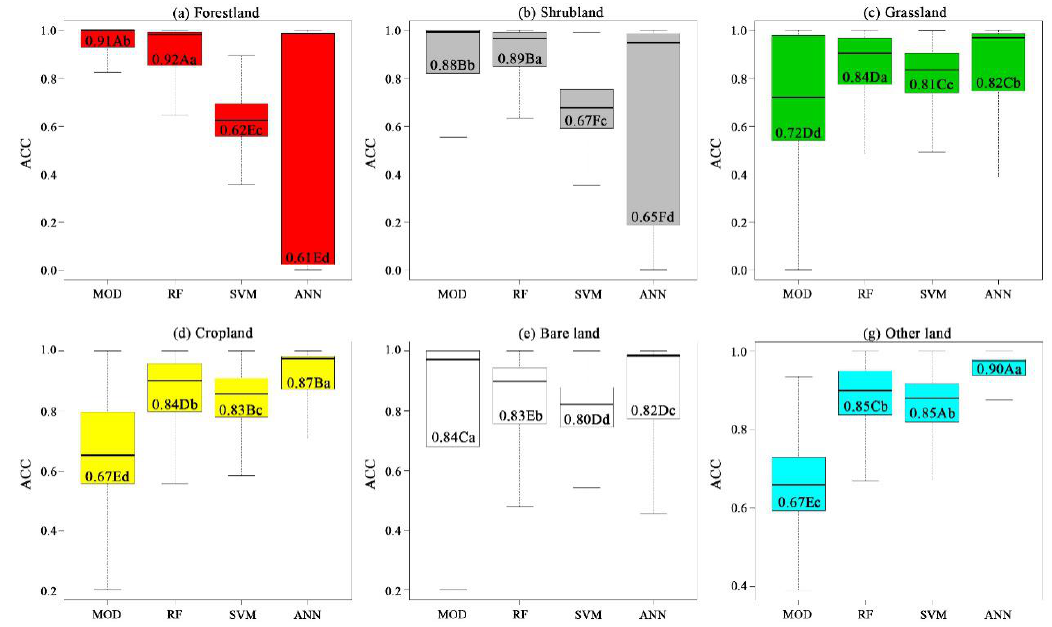
Figure 6. Boxplots of the accuracy distributions of MOD10A1 (MOD), random forest (RF), support vector machine (SVM) and back-propagation artificial neural network (ANN) under different land cover types over the Tibetan Plateau. Labels are composed of the average accuracy and the results of the significance tests (in the case of p < 0.05). The uppercase letters represent the accuracy of the specific model from high to low (A to D) among different land cover types, while the lowercase letters represent the accuracy from high to low (a to d) among the four FSC models for each land cover type. Table 4. Overall average accuracy (ACC) of MOD10A1 (MOD), random forest (RF), support vector machine (SVM) and back-propagation artificial neural network (ANN) over the Tibetan